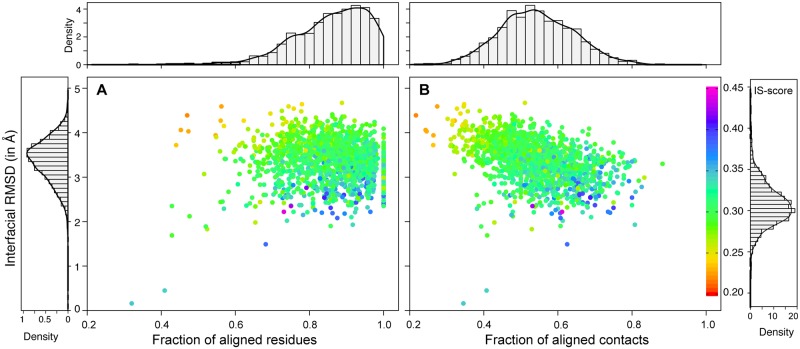
Plots of the best interface matches for Domain-CC-2 dataset.Scatter plot of the interfacial RMSD versus (A) fraction of aligned residues (fres) and (B) fraction of aligned contacts (fcon) for the closest match of 1511 domain-domain interfaces extracted from proteins having only two CATH classified structural domains. Each point is represented using color gradient based on IS-score. Histogram and density plots of RMSD, fres, fcon and IS-score are shown surrounding main scatter plot.